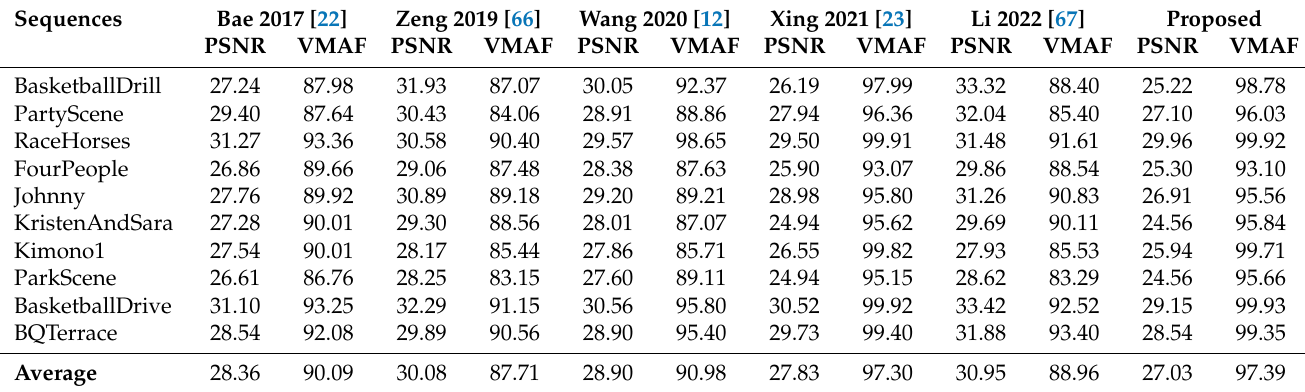
Table 2. Video multimethod assessment fusion